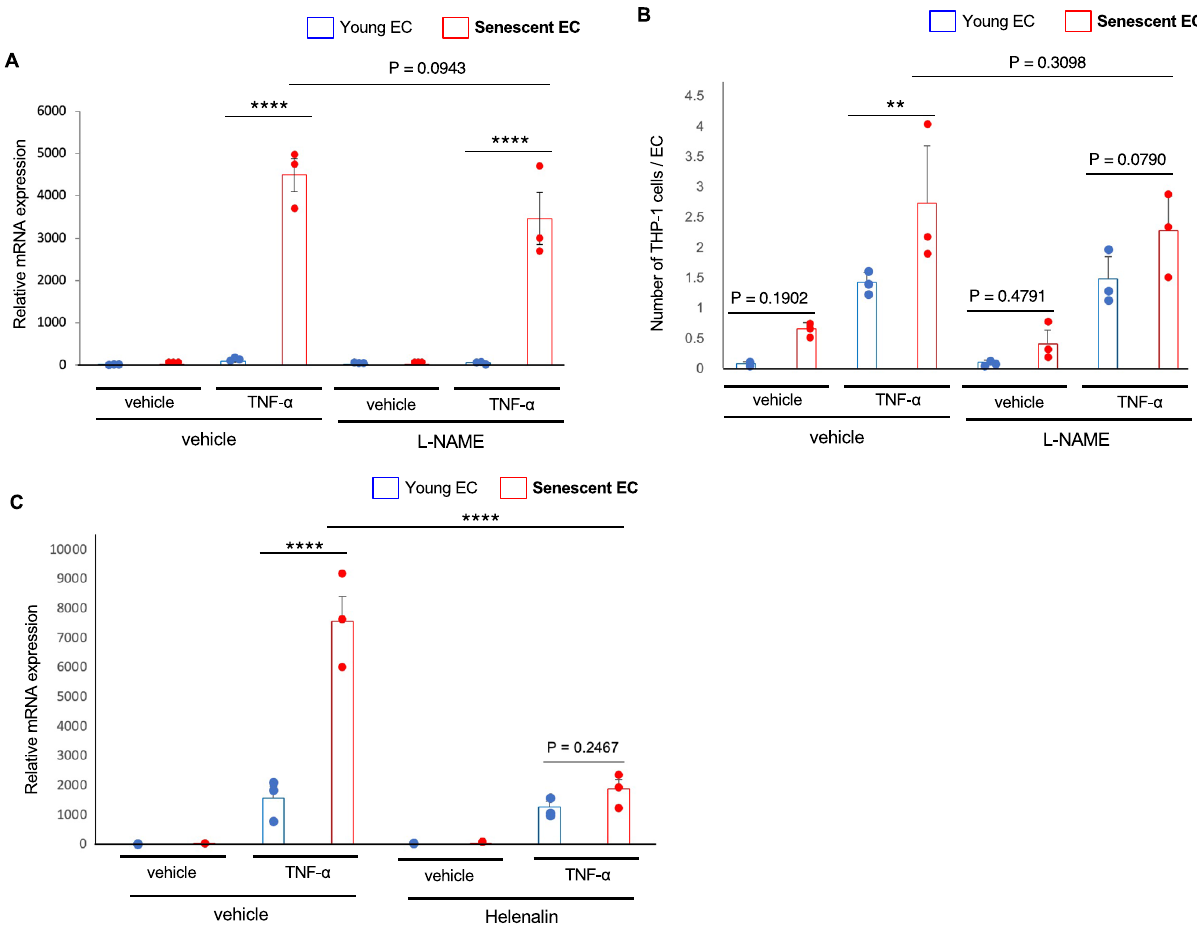
Figure 4. NF-κB signaling is critically involved in the hyper-inflammability in senescent ECs. ( A ) Inhibition of NOS using L-NAME did not abolish the enhanced VCAM-1 induction in response to TNF-α in senescent ECs (n = 3 each). ( B ) Inhibition of NOS using L-NAME did not abrogate the enhanced monocyte adhesion in senescent ECs treated with TNF-α (n = 3 each). ( C ) Inhibition of NF-κB signaling using helenalin abolished the enhanced VCAM-1 induction in response to TNF-α in senescent ECs (n = 3 each). Data are presented as mean ± SEM. ** p < 0.01 and **** p <